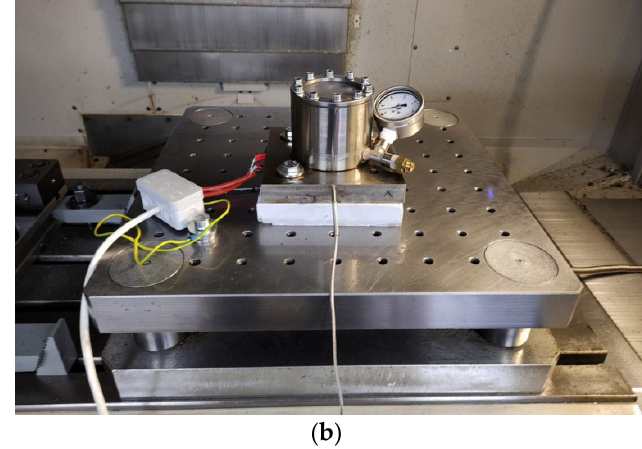
Figure 1. ( a ) Structural diagram and ( b ) view of experimental setup.